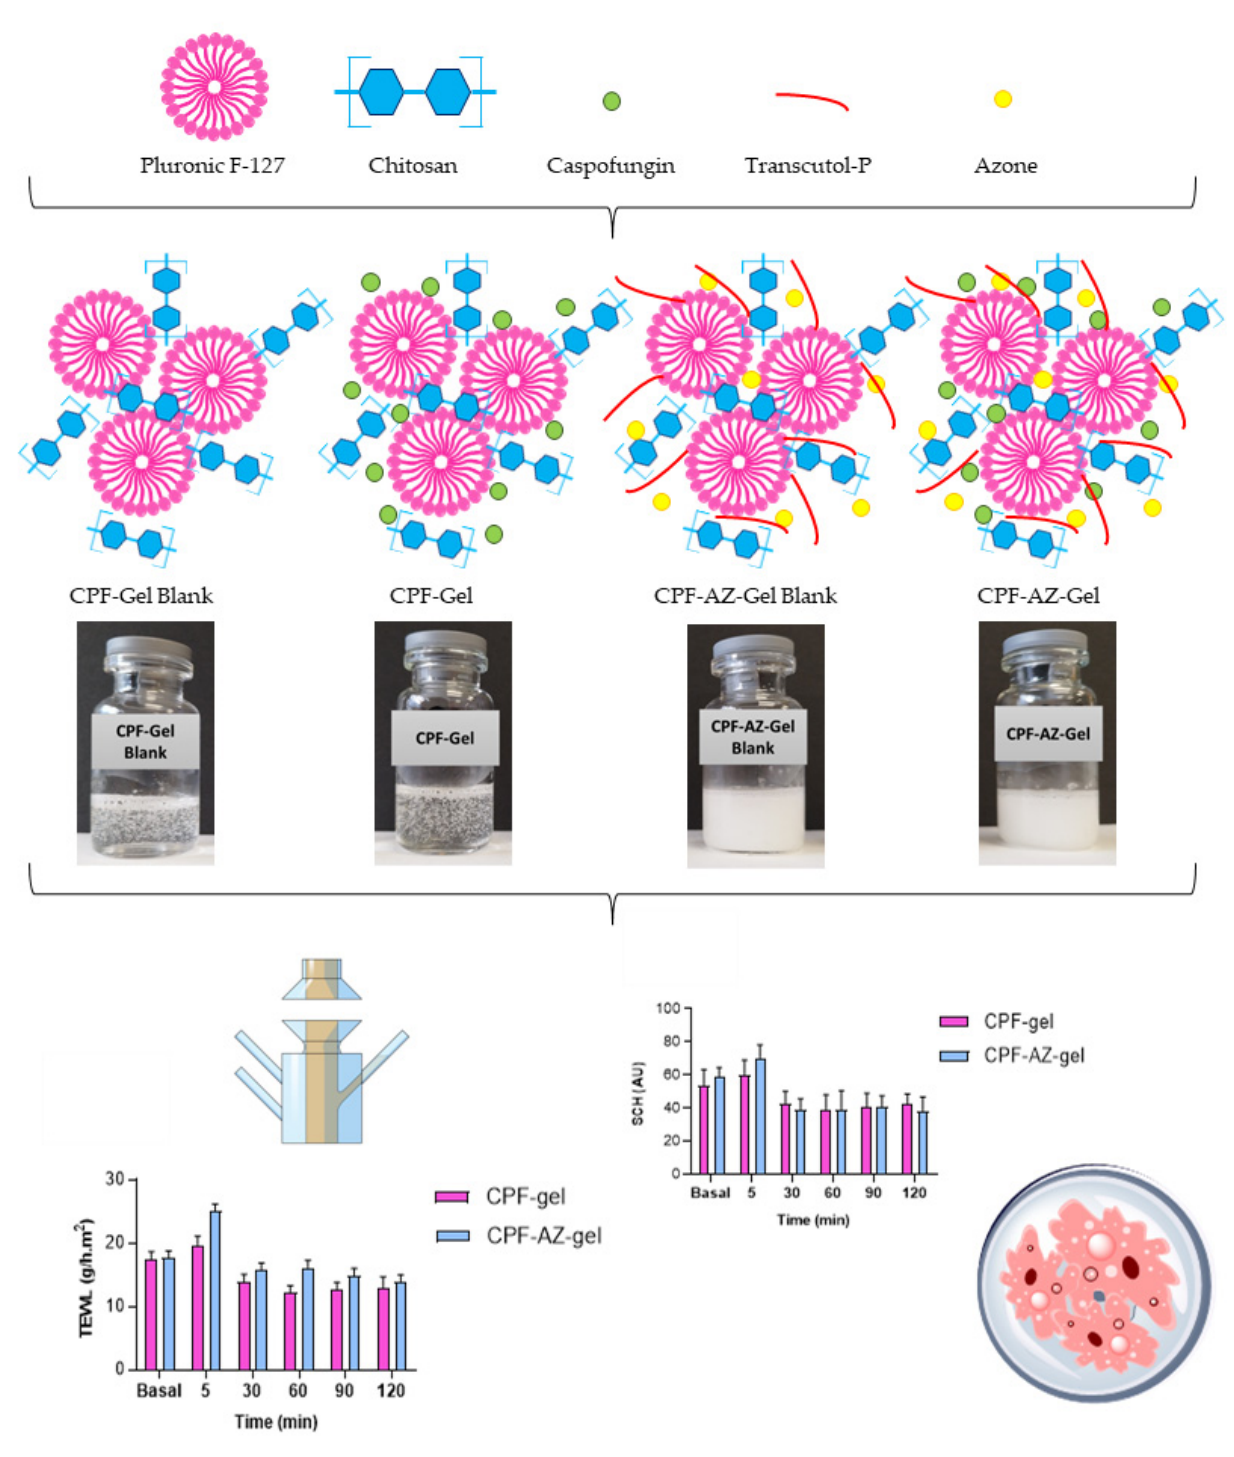
Figure 2. Schematic representation of the development of the loaded and unloaded hydrogels composed of pluronic F-127 and chitosan, with and without permeation enhancers, and the evaluation of the formulations .